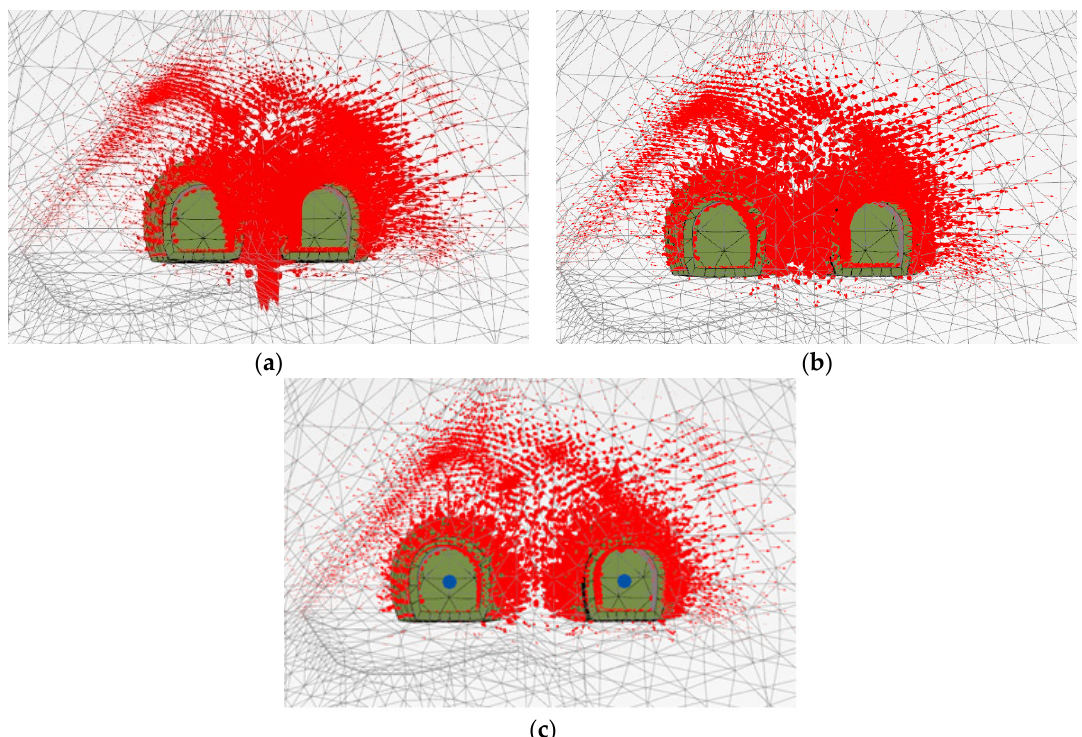
Figure 8. Load-horizontal displacement curve with anchorage spacing.